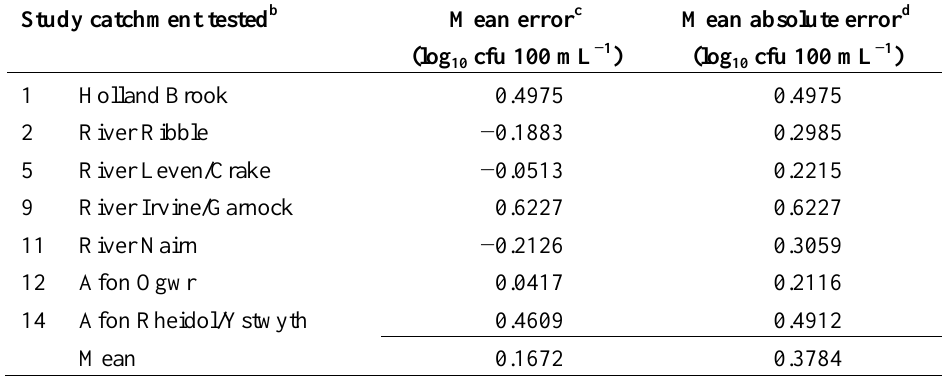
Table 7. Inter-study transfer errors a in high-flow, population-based enterococci